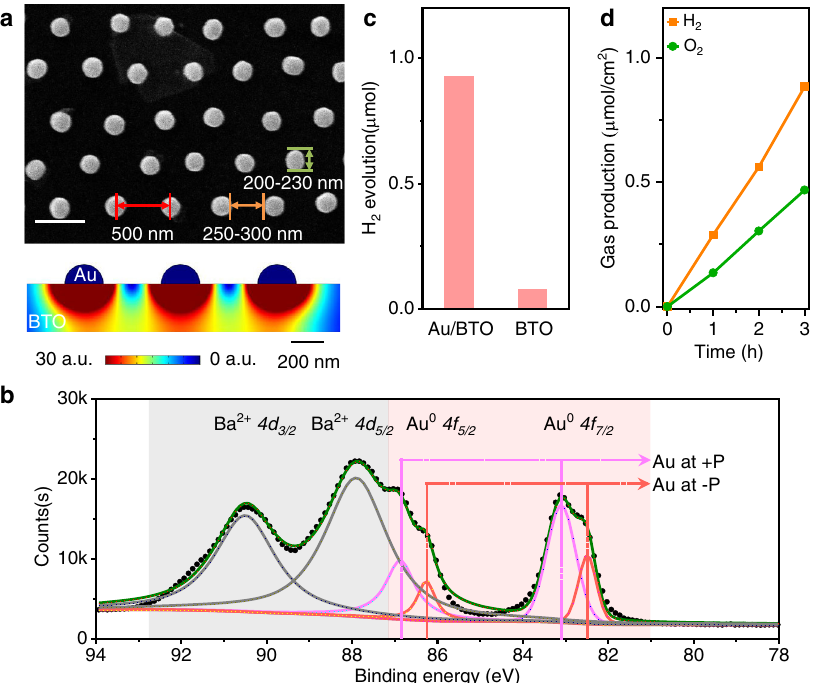
Fig. 4 Au arrays/BTO ferroelectric photocatalysts. a SEM image of an Au array on a BTO single crystal and simulated electric fi eld intensity distribution of Au array/BTO. b High-resolution XPS pro fi les of Au array/BTO. c Hydrogen evolution reaction of Au array/BTO and BTO. d Overall water splitting reactions of Au array/BTO with cocatalysts in pure